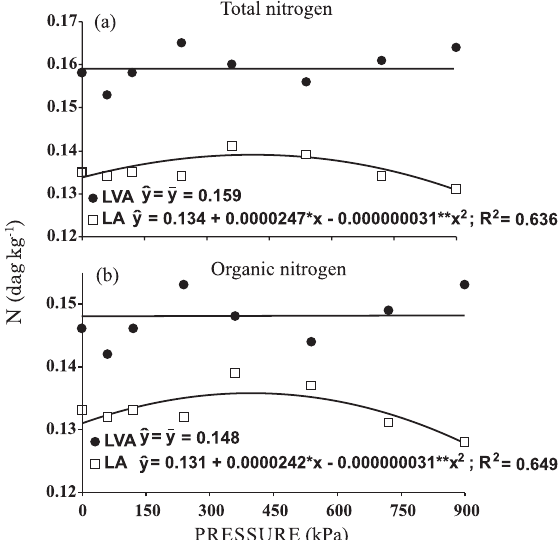
Figure 6. Total (a) and organic nitrogen (b) in two Oxisols subjected to increasing compaction pressures. (***, **, *: significance of the coefficients by the F-test, respectively, at the level of 0.1, 1 and 5